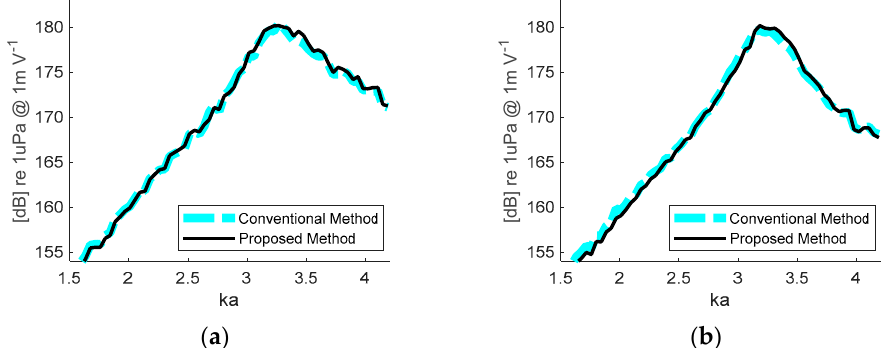
Figure 13. Comparison of transmitting voltage responses (TVRs) calculated by the proposed method (solid line) and the conventional FEM (thick dashed line) when ( a ) θ = 0 ◦ and ( b ) θ = 30 ◦ .